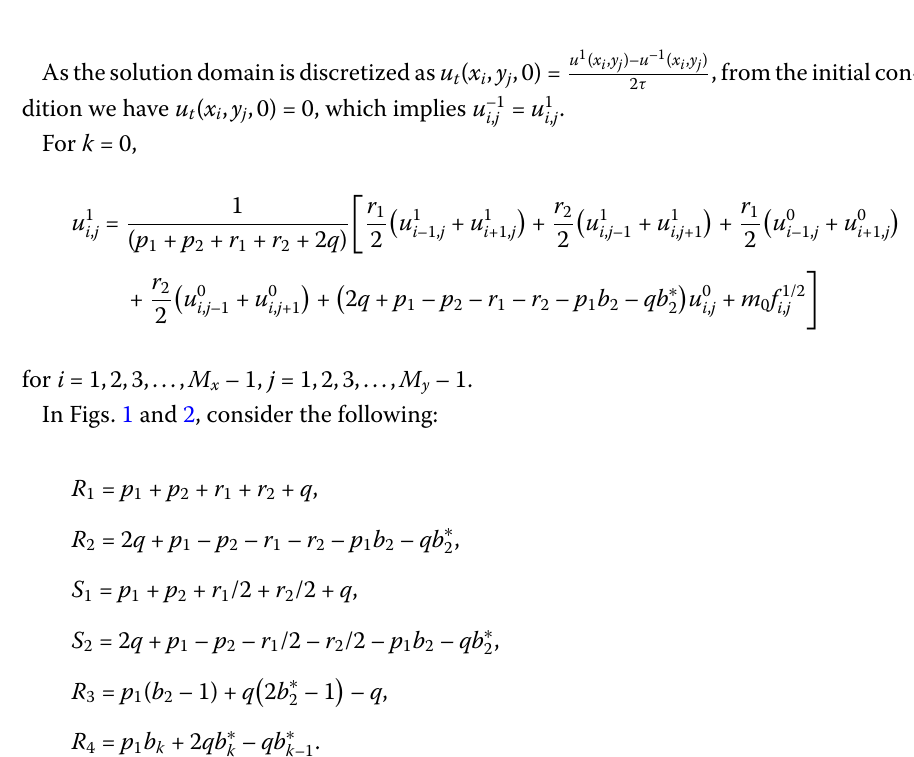
1 ( x i , y j )– u –1 ( x i , y j ) , from the initial 2 τ